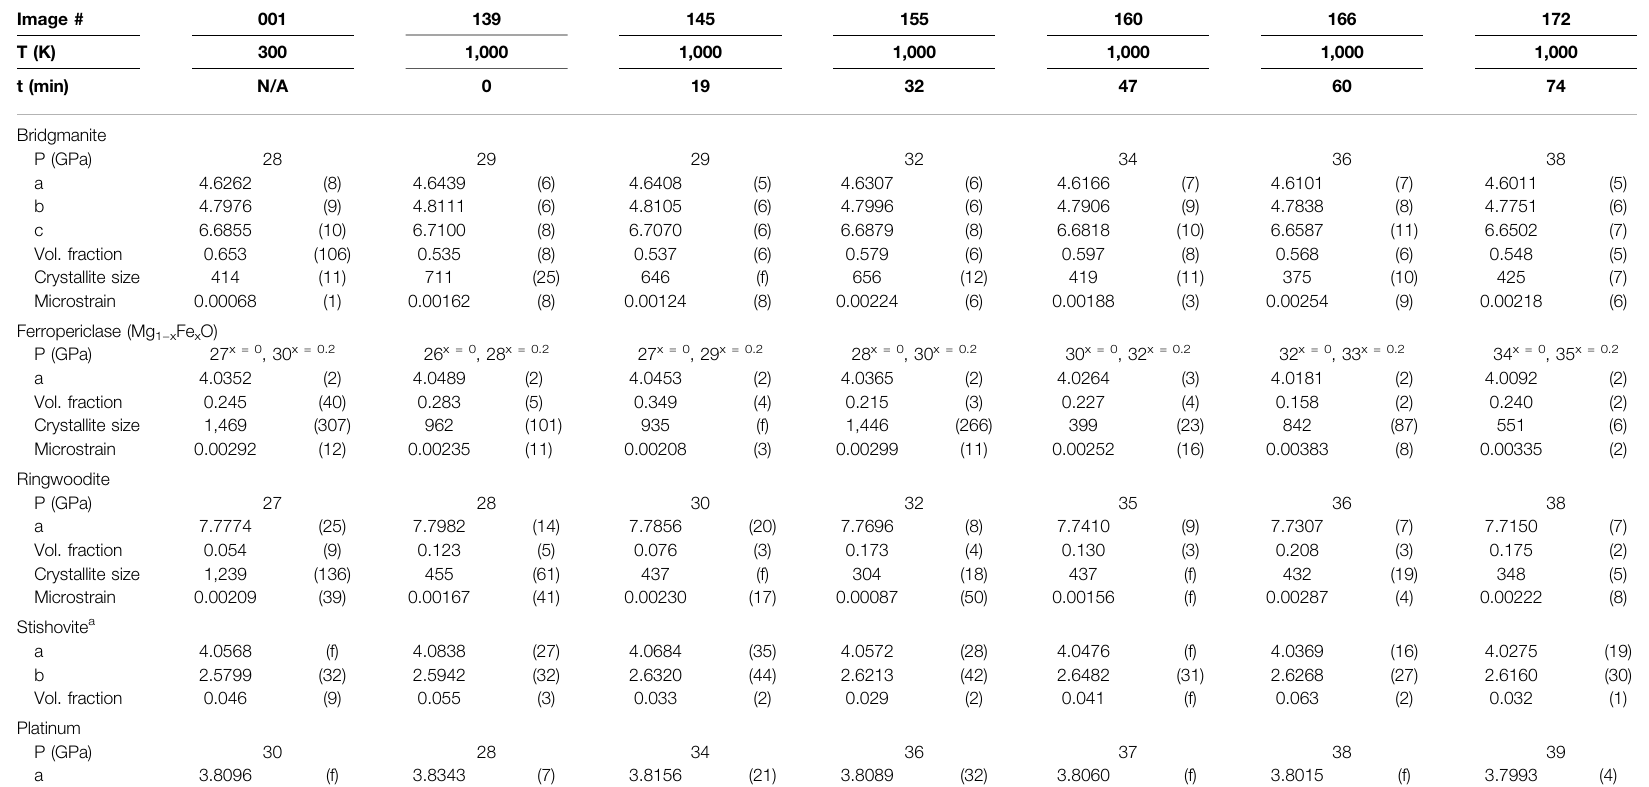
Timet (cid:2) 0isde fi nedasthe fi rstexposuretakenaftertheaggregatetemperatureintheresistiveheatedradialdiamondanvilcellreached1,000 K.Pressuresaredeterminedfromlatticeparametersandequationsofstateforplatinum(Feietal., 2007),bridgmanite(using13%FefromWolfetal.,2015),ferropericlase(Vinniketal.,2010),andringwoodite(using9%FefromNishiharaetal.,2004).1 σ standarddeviations(onthelastdigits)fromRietveldrefinementaregiveninparenthesis. Fixed parameters are indicated by (f). Volume fraction for PtB and Pt are both < 1%. Uncertainties on temperature (T) and pressure (P) are ± 60 K and ± 1 GPa respectively. a Crystallite size and microstrain fi xed to 329 and 0.00143,